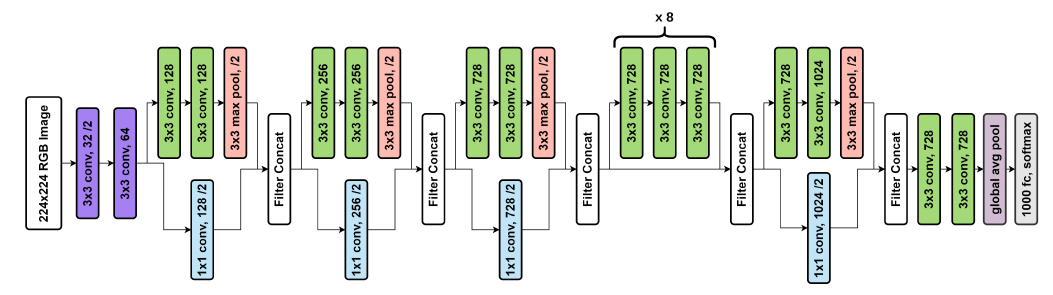
Figure 7. Architecture of the Xception